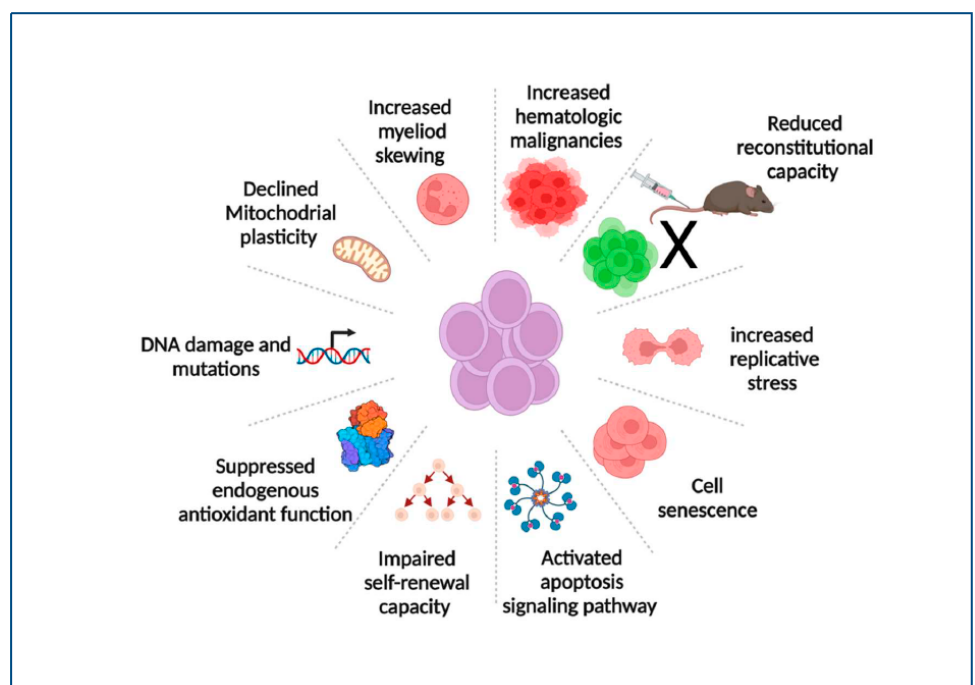
Figure 2. Hallmarks of HSC ageing. Aged HSCs exhibit impaired self-renewal and reconstitutional capacities and increased replicative stress. They are also characterized by cell senescence, increased cell apoptosis, and declined mitochondrial biological functions. Aged HSCs are associated with a deficiency in the DNA repair pathway, higher mutation rates, increased myeloid lineage skewing, and an increased incidence of hematological malignancies. Created with BioRender.com, accessed on 19 June